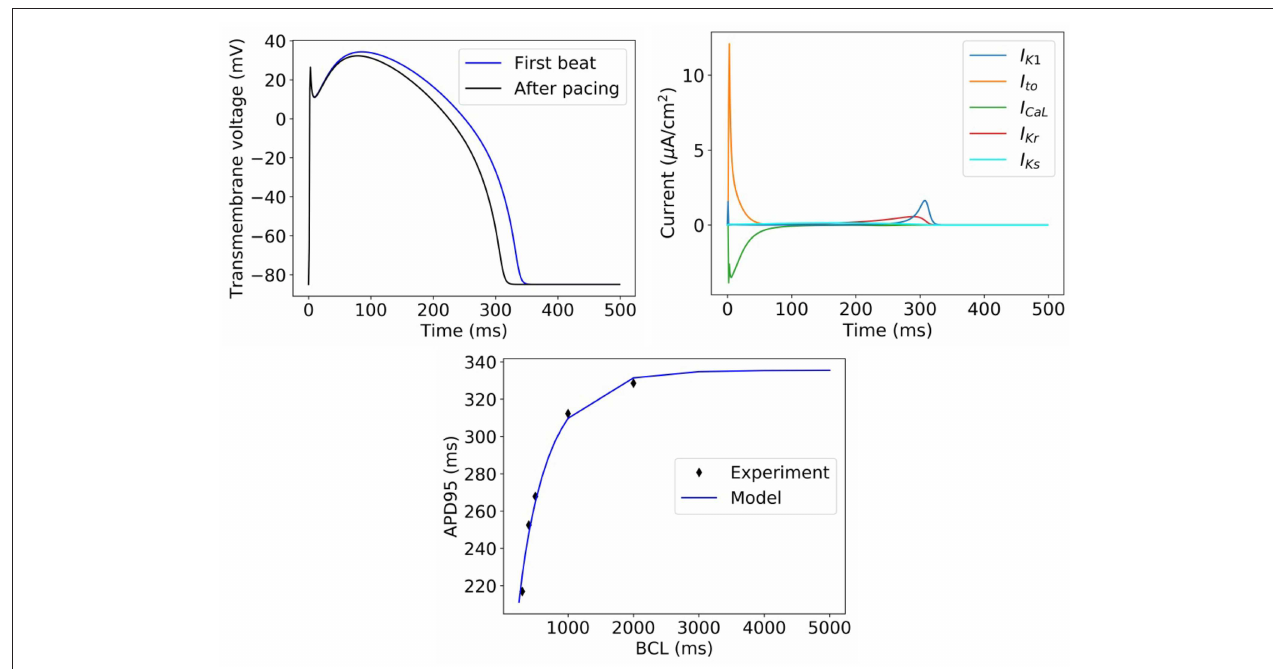
FIGURE 2 | Behavior of model with nominal parameter values. Top left : Action potential in first beat and after pacing. Top right : Ionic current transients in paced action potential. Bottom : dynamic restitution properties, compared to experimental data used for model calibration (BCL = basic cycle length).